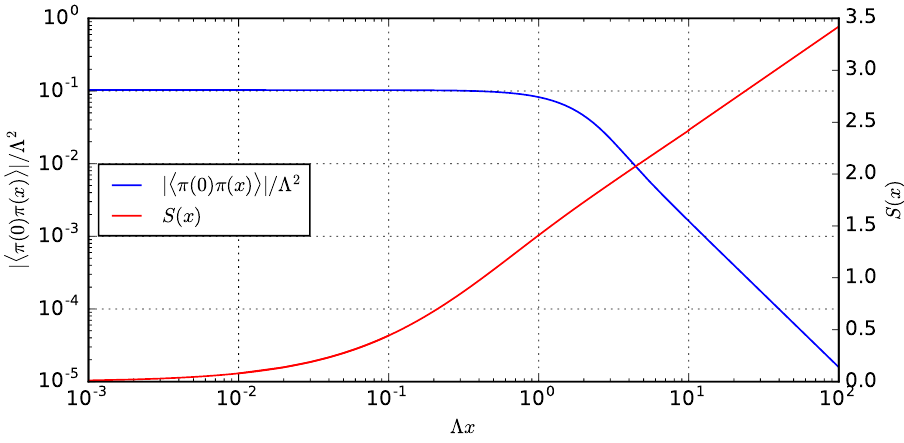
Figure 1 . Left vertical axis . Plot of the h (cid:25)(cid:25) i two-point correlation function for a cMERA with target theory a 1+1 free boson. Right vertical axis . Entanglement entropy of an interval vs. length of the interval. for the same cMERA